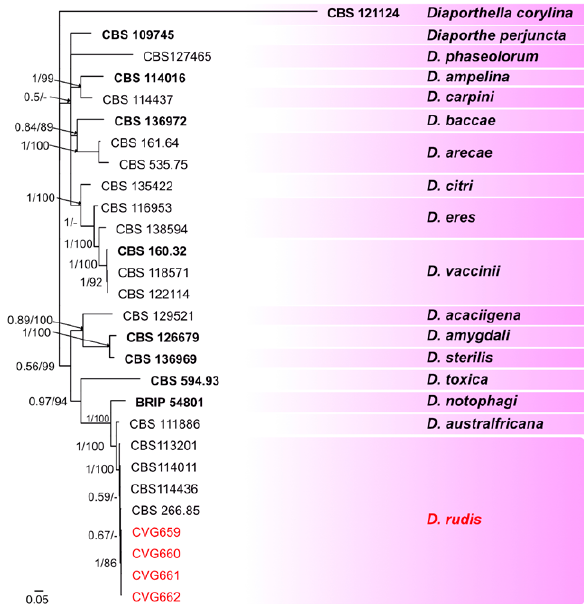
Figure 3. Consensus phylogram of 982 trees resulting from a Bayes- ian analysis of the combined ITS, tef1 and tub2 sequences of Neo- fusicoccum strains. Bayesian posterior probability values and boot- strap support values are indicated at the nodes. The tree was rooted to Diplodia seriata (CBS 110875).